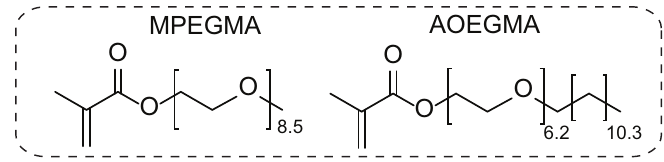
Figure 1. Monomer structures and